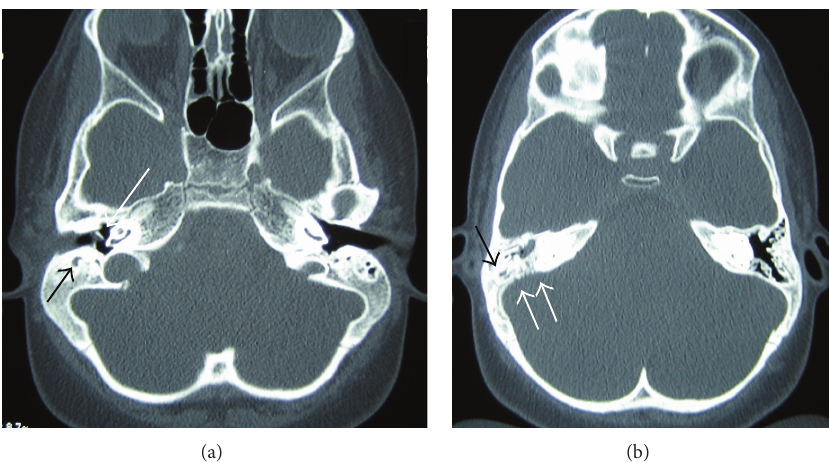
Figure 2: (a) and (b), axial sections from the preoperative temporal bone CT (without contrast) of the presented case. (a) Section through the mesotympanum showing the poorly developed mastoids on both sides. The right mastoid cells are filled with soft tissue (short arrow), while the middle ear cavity is free of effusion (long arrow). (b) Section at the level where the bone erosion can be observed (double arrows). Again, the right mastoid air cells and antrum are cloudy (short arrow).